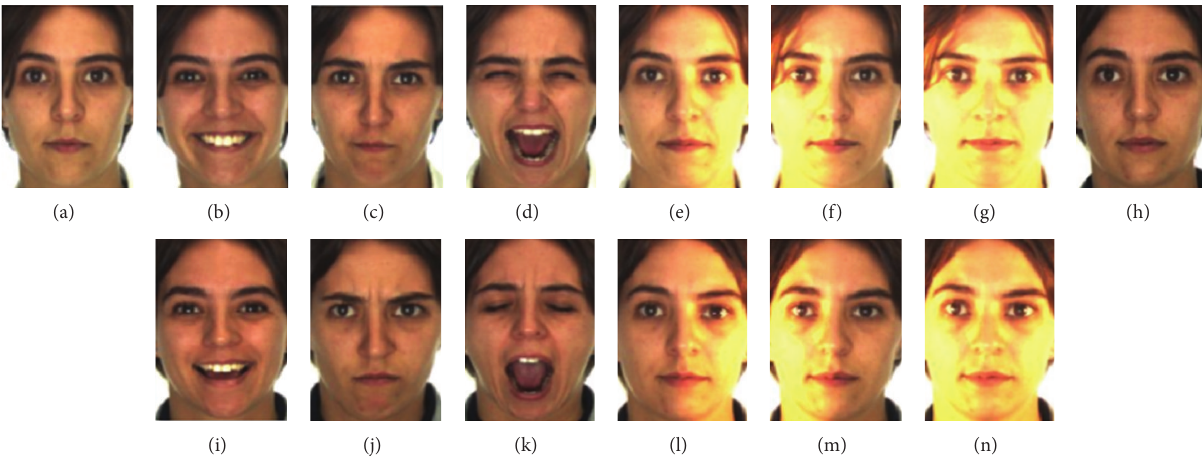
Figure 5: Sample images for one subject of the AR database. The images of (a) neutral expression, (b) smile, (c) anger, (d) scream, (e) left light on, (f) right light on, (g) all sides with light on, and the images of (h)–(n) under the second session.